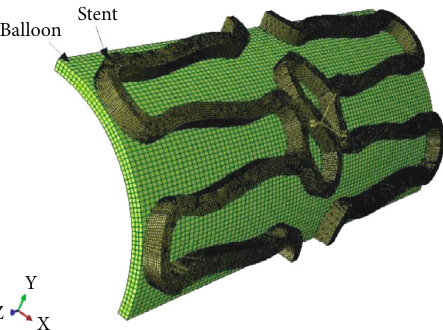
Figure 5: Meshed model of unit cell-balloon assembly.